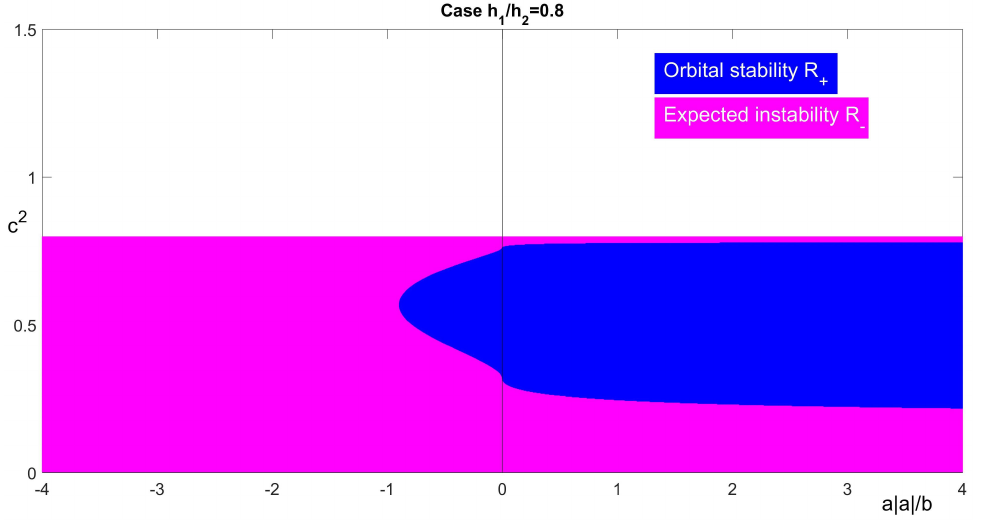
Figure 3. The region of orbital stability ( d (cid:48)(cid:48) > 0) for h 1 / h 2 = 0.8, a | a | left half-plane is for a < 0; right half-plane is for a > 0.